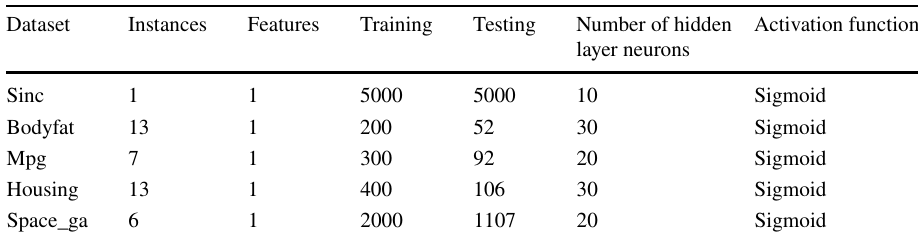
Table 4 Regression dataset